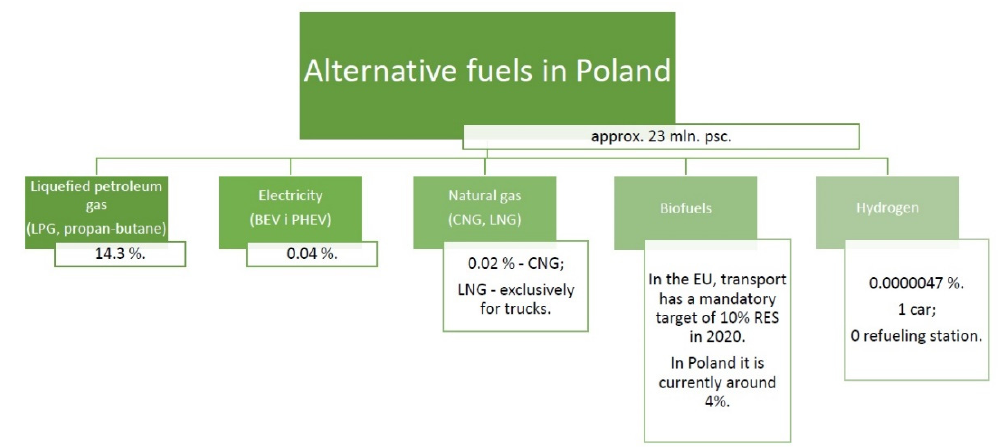
Figure 1. Current and developing alternative fuel technologies in operation. Own development based on [17–20] .